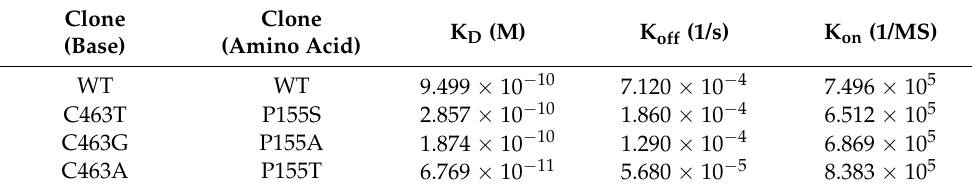
Table 2. Affinities of different mutations of CD19 antibodies.